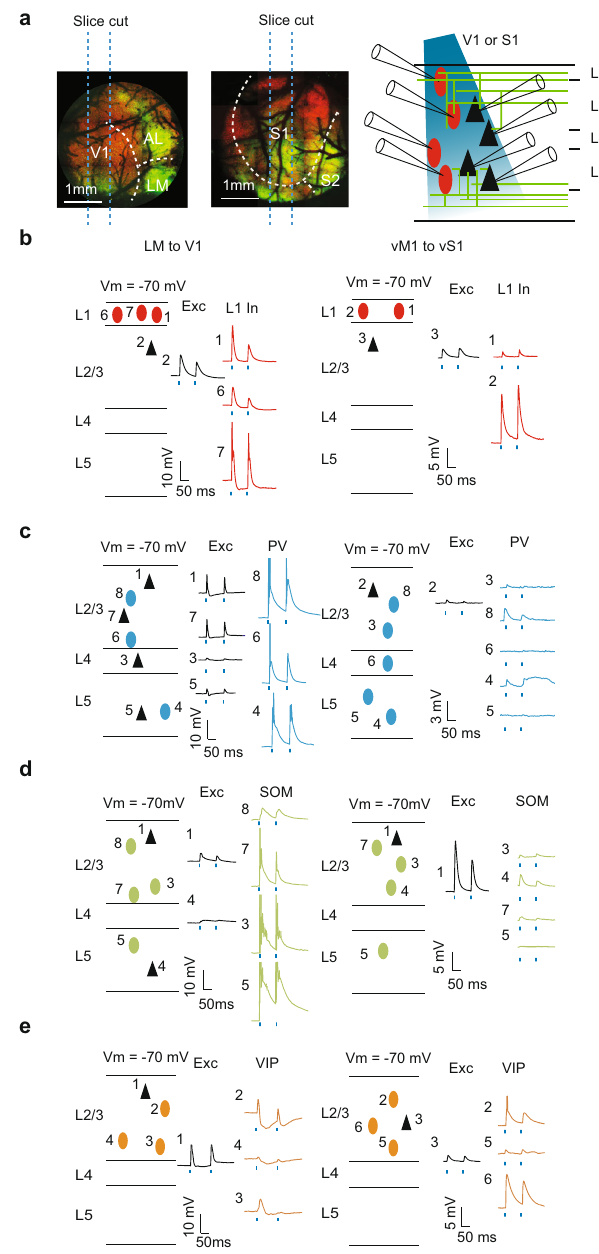
Fig.2|Exampleslicesforconnectivity.a Experimentalparadigm.Left:Parasagittal slicescontainingV1orvS1Right:LMorvM1wereexcludedfromtheslices,whilethe axon terminals from LM or vM1 were included in the slices. b Example slice recording of L1 interneurons (red ovals) and pyramidal cells (black triangles) in eitherV1(left)orvS1 (right).Numbersrefertothechannelnumberof the recording system. The blue dots mark the 2ms blue LED pulses. c Example slice recording of PV+ interneurons (blue ovals) and pyramidalcells (black triangles) in either V1 (left) or vS1 (right). d Example slice recording of SOM+ interneurons (green ovals) and pyramidal cells (black triangles) in either V1 (left) or vS1 (right). e Example slice recording of L2/3 VIP+ interneurons (orange ovals) and pyramidal cells (black tri- angles)ineitherV1(left)orvS1(right).SourcedataareprovidedasaSourceData fi